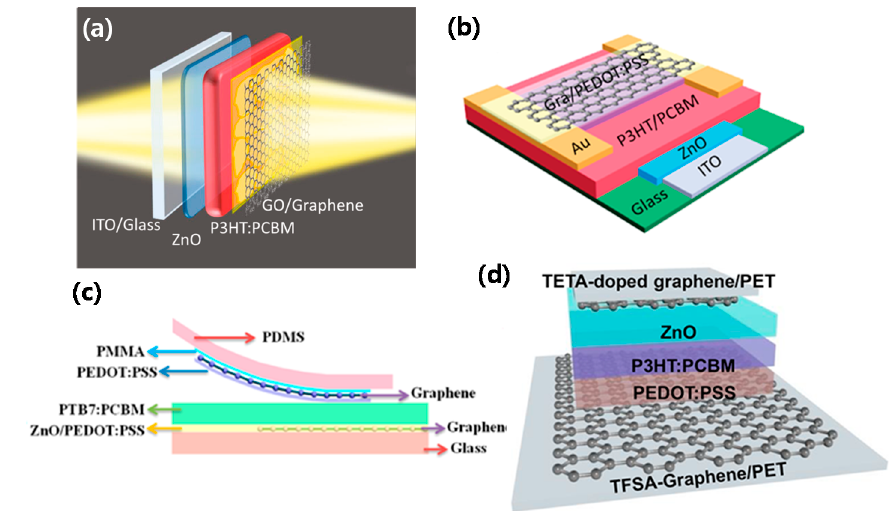
Figure 3. Schematic diagram of graphene-TCE-based various STOSC structures: ( a ) ITO/ZnO/P3HT: PCBM/graphene oxide (GO)/graphene top electrode. Reprinted with permission from [34].